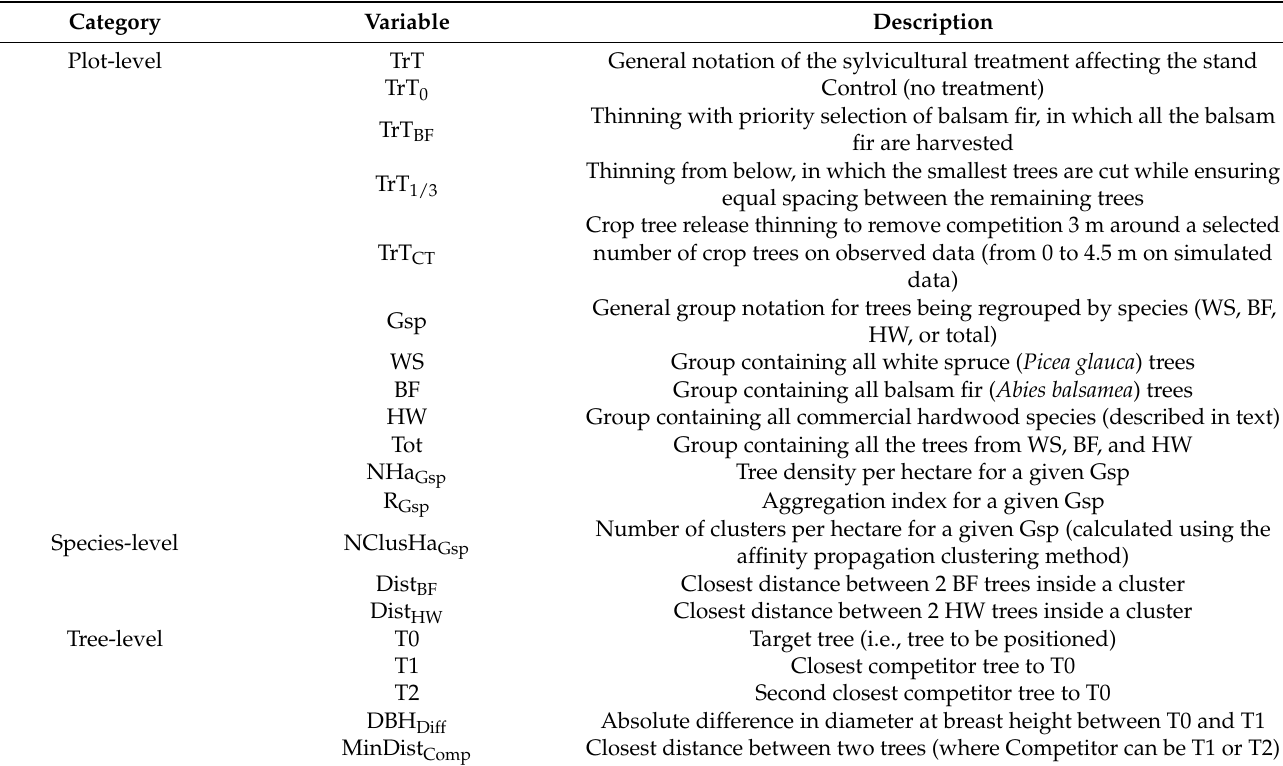
Table 2. Definition and abbreviation of the variables